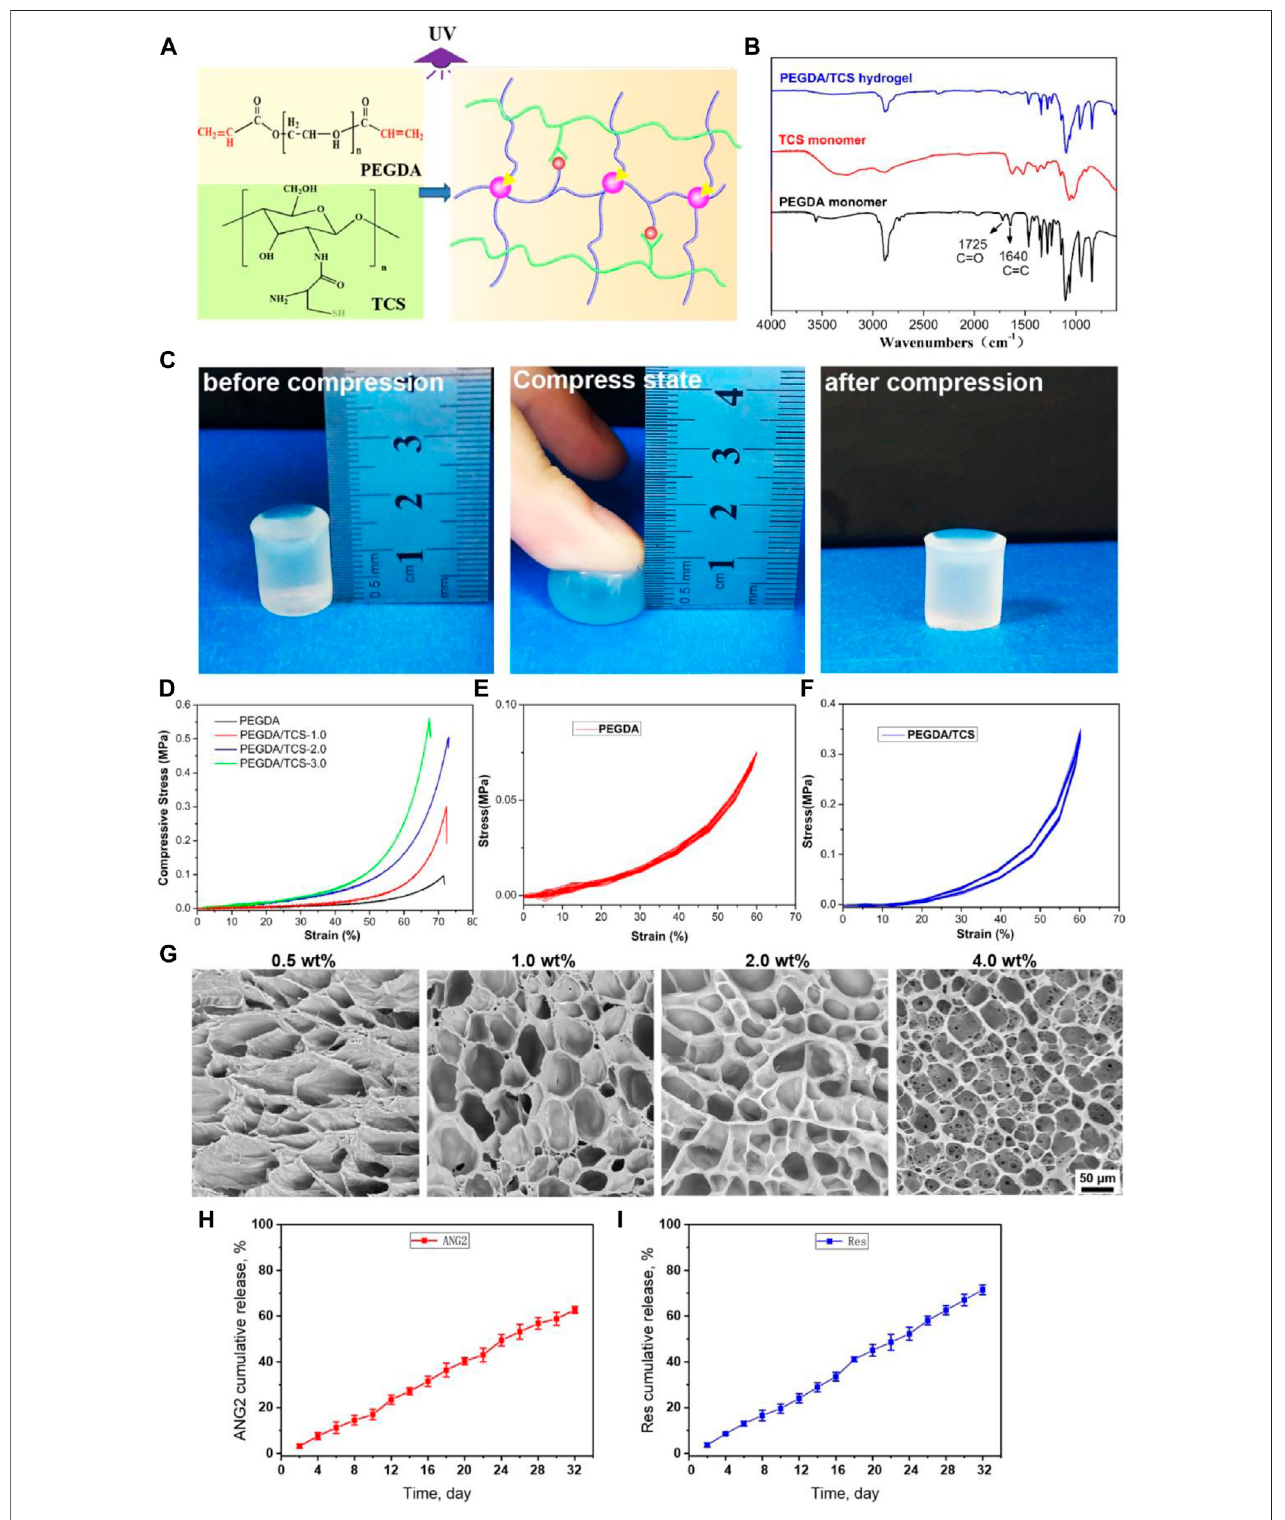
FIGURE 6 | Scheme for the fabrication of PEGDA/TCS hydrogel (A) , FTIR spectra (B) , schematic of hydrogel compression: (A) before compression, (b) under compression and (c) after compression (C) , compressive stress-straincurves (D) ,cycliccompressivestress-straincurvesofPEGDA (E) and PEGDA/TCS (F) ,and SEM images of PEGDA/TCS hydrogel for different proportions of TCS (G) . The releases curve of ANG2 (H), and Res (I) from PEGDA/TCS hydrogel. The values are represented as mean ± SD ( n (cid:1) 3). The scale bar is 50 μ m.